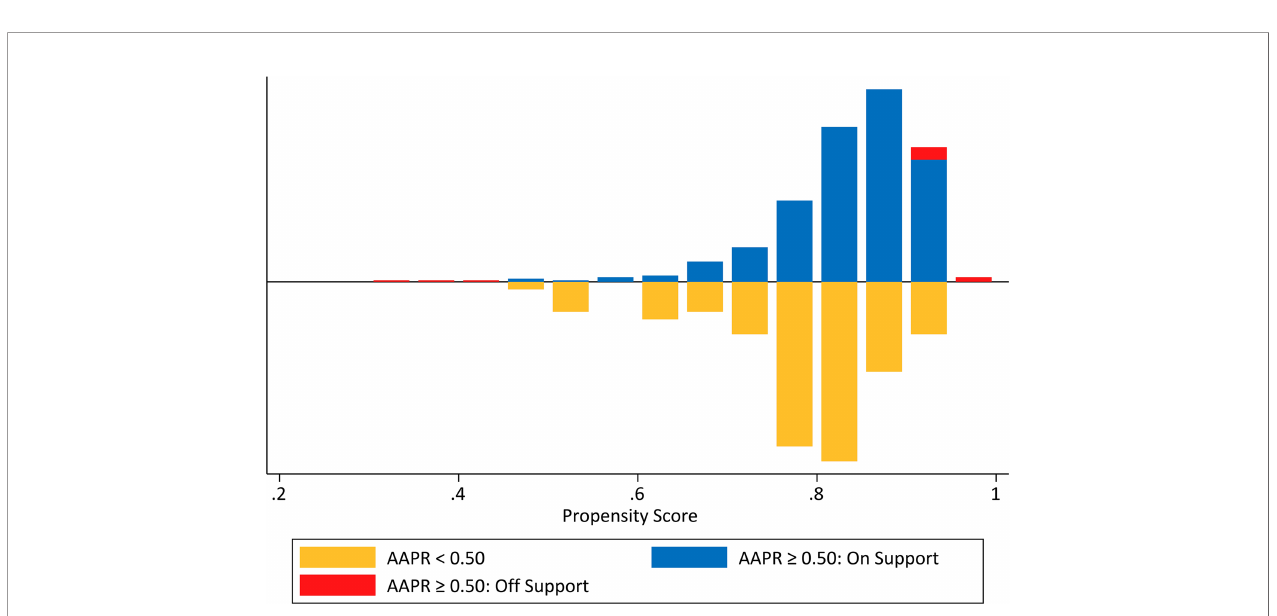
FIGURE 8 | Mirrored histogram presenting the propensity score distribution and the overlap between unmatched and matched samples in the two AAPR